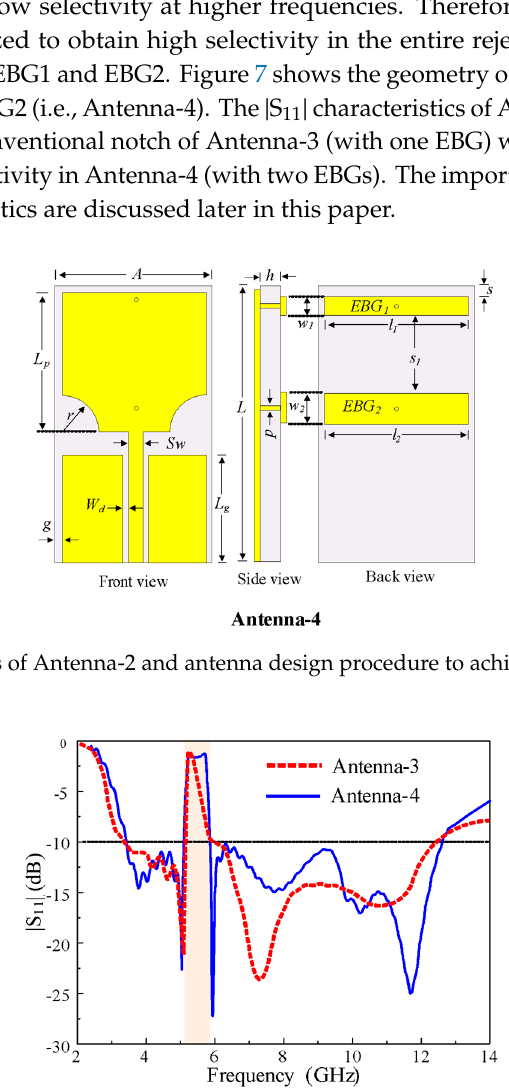
Figure 8. |S 11 | characteristics of Antenna-3 and Antenna-4.